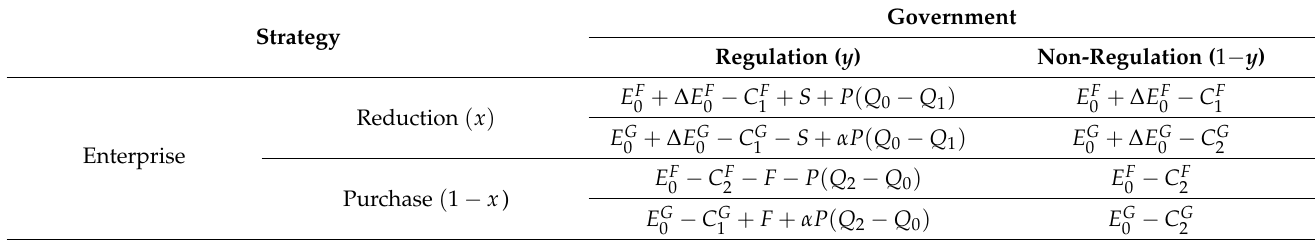
Table 2. Evolutionary game payment matrix of carbon trading between government and enterprise. Strategy